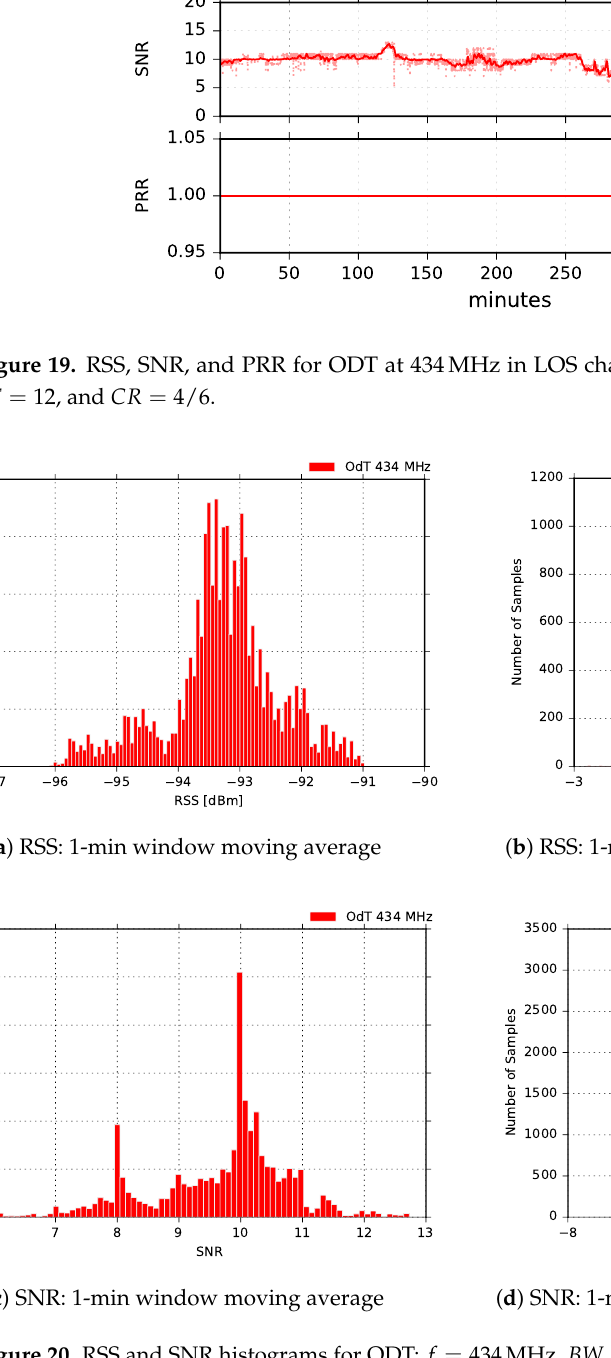
Figure 20. RSS and SNR histograms for ODT: f = 434MHz, BW = 125kHz, SF = 12, CR = 4/6,